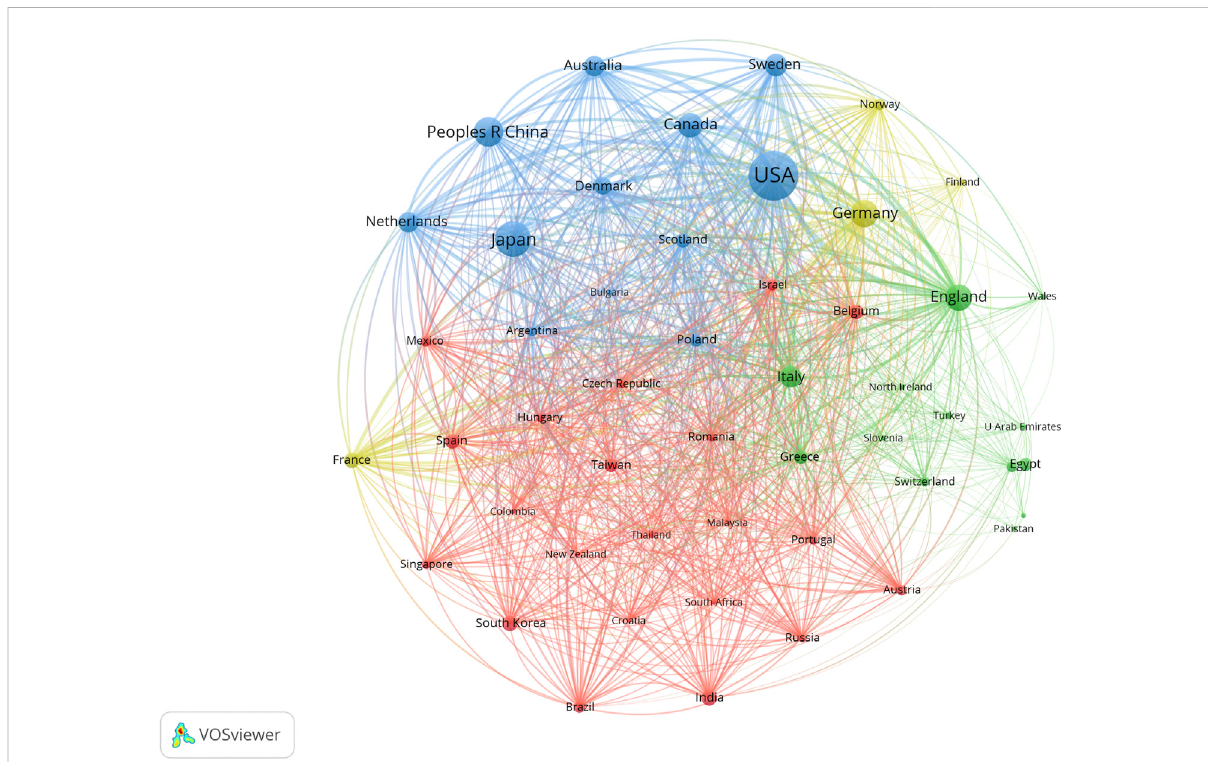
FIGURE 3 VOSviewer network visualization map of countries or regions involved in SGLT2 inhibitor research. Collaboration analysis of the top 50 of 93countriesorregions. Nodesizerepresentstheco-authorshipfrequency,andthelinebetween twonodesrepresents acollaborationbetweenthe two countries, regions, or institutions; the thicker the line, the closer the